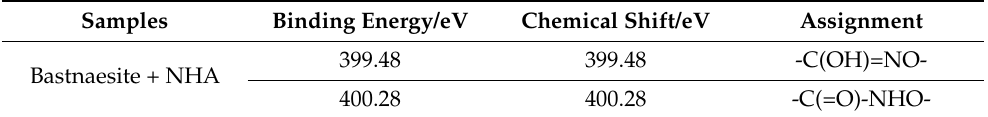
Table 10. Analysis results of N 1 s XPS spectra of bastnaesite samples untreated and treated with